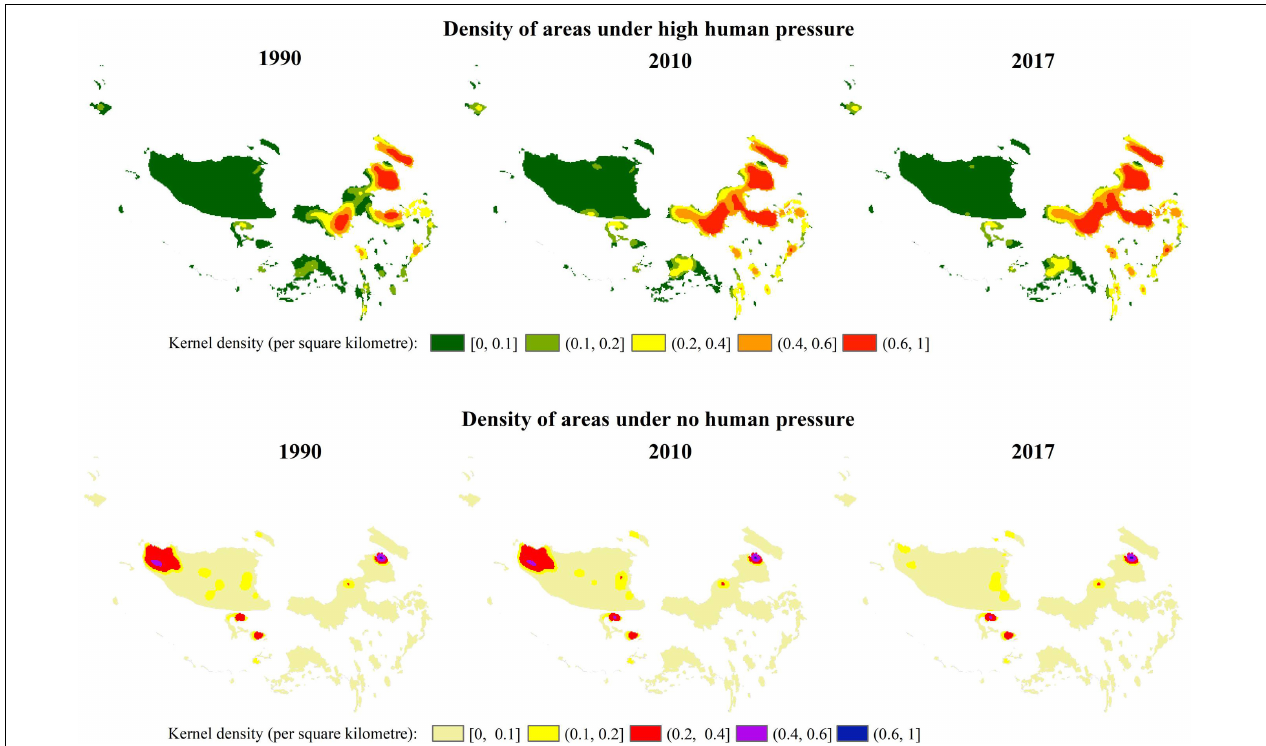
FIGURE 5 | Aggregation areas of KBAs with human pressure above 10 and under no human pressure in KBAs during 1990–2017.